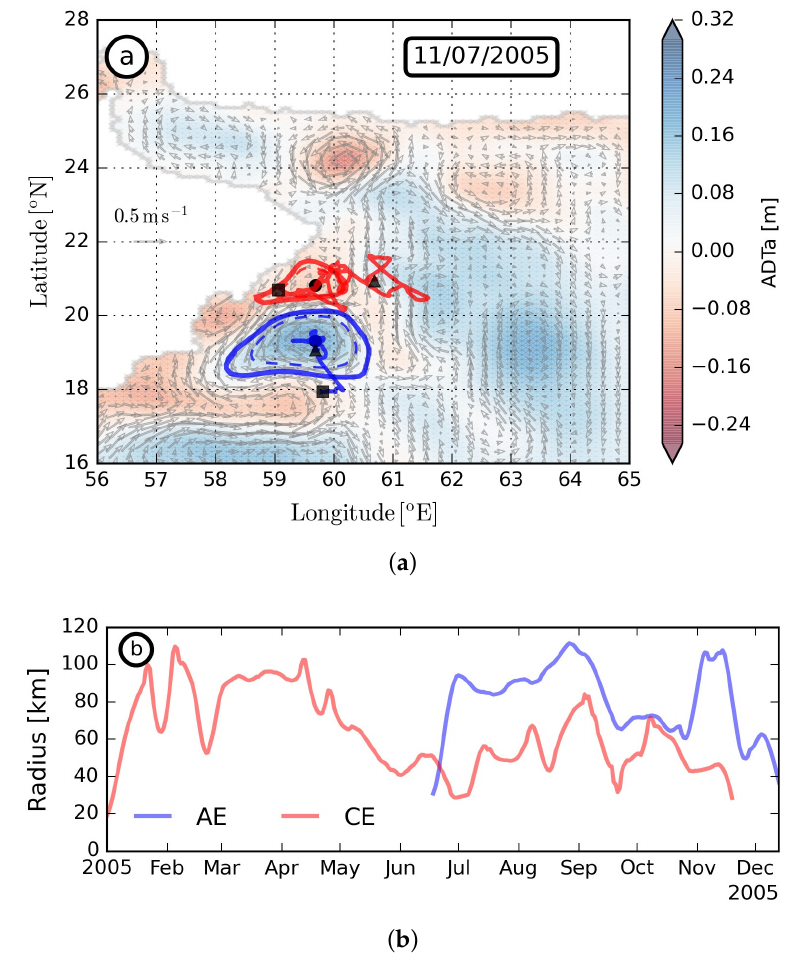
Figure A2. ( a ) Absolute Dynamic Topography anomaly for the 2005 year (snapshot); blue and red contours are for anticyclones and cyclones respectively, dashed contours are for eddy core, and solid contours for the last closed contour. The black dot represents the anticyclone and cyclone instantaneous center position. The solid red and blue trajectories are for cyclone and anticyclone, respectively during their lifetime. The black triangle and square represent the initial and final position of each eddy, respectively; ( b ) time series of the cyclone and anticyclone radii for 2005. As can be seen in the following two figures, in 2005 and 2009, only a weak (and intermittent) dipole is observed near Ras al Hadd. The largest and most stable dipole lies southwest of Ras al Hadd. Thus, these two years are considered as